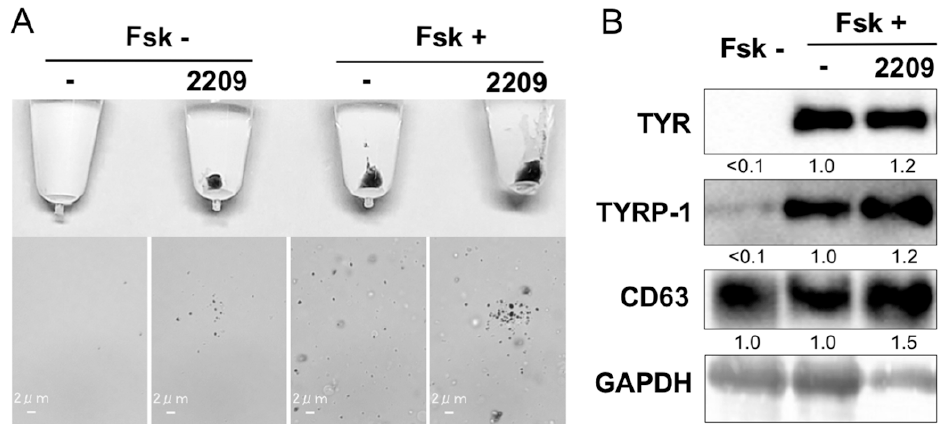
Figure 5 . ( A ) B16F10 cells were treated with GIF-2209 (10 μ M) in the presence of Fsk (20 μ M) for 24 h. The cells were recovered, and melanosomes were precipitated by centrifugation. n = 3. ( B ) The melanosome lysate (10 μ g) was used for western blot analysis. Signal intensity was normalized to that of GAPDH. The images are representative of triplicate experiments.